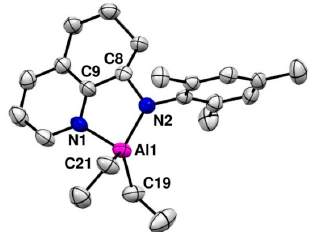
Figure 2. ORTEP of the molecular structure of Al5 . Ellipsoids at 50% probability level. Hydrogen atoms are omitted for clarity. Selected distances (Å) and angles (deg): A1–N1 1.980(3), A1–N2 1.844(3),